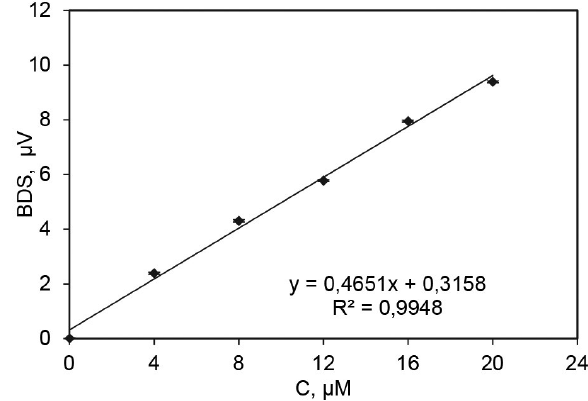
Figure 5. Calibration curve for Fe(II) determination.